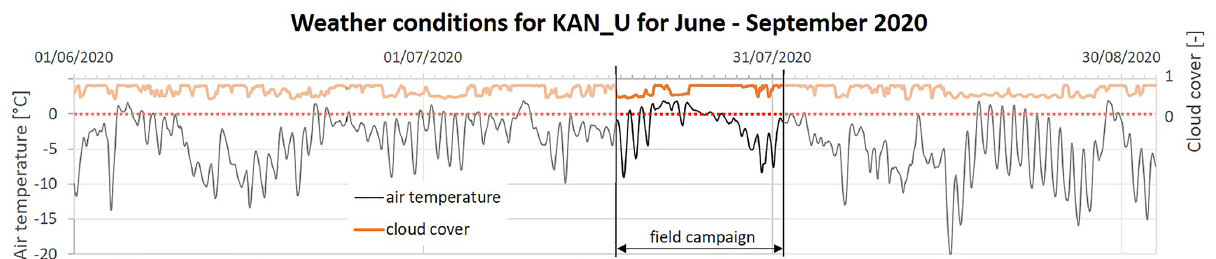
Figure 9. Air temperature and cloud cover at KAN_U weather station from 1 June to 1 September 2020 (source: PROMICE; Ahlstrøm et al., 2008; How et al.,